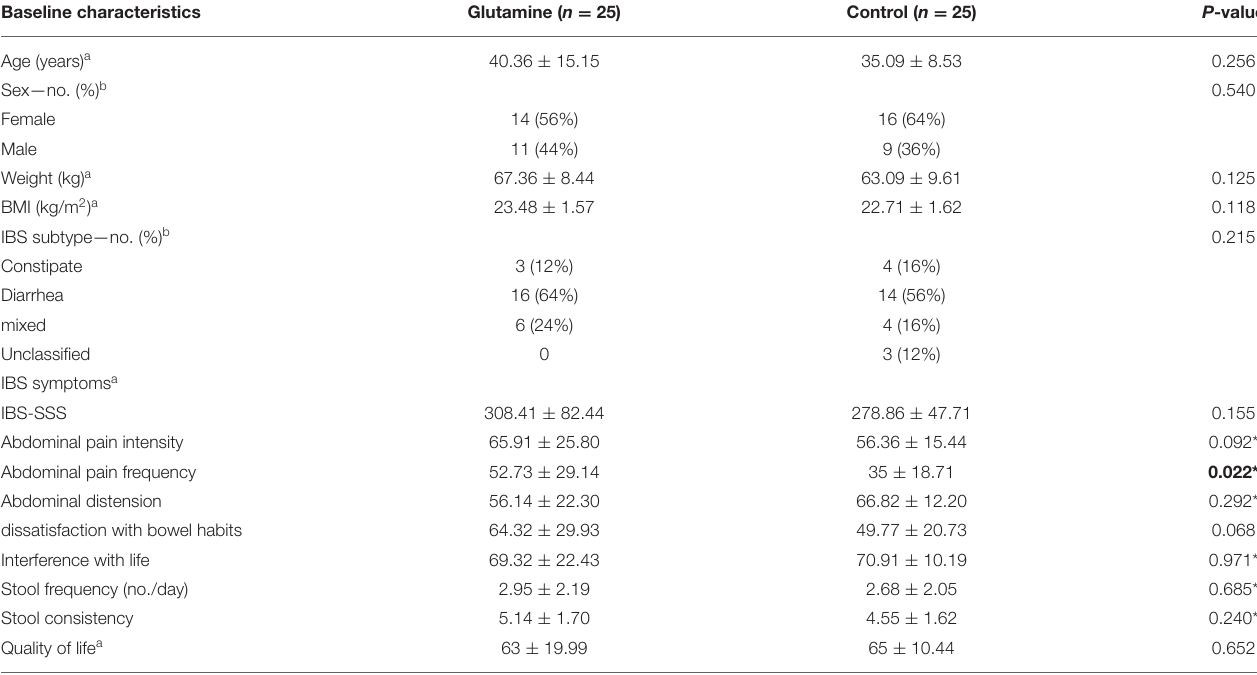
TABLE 1 | Characteristics of participants with irritable bowel syndrome at the baseline. Baseline